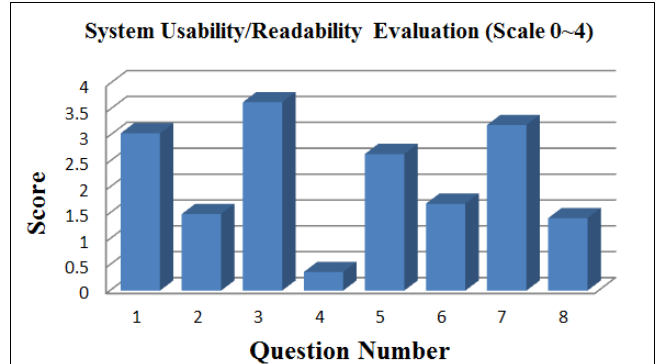
Figure 14. UFIT usability/readability evaluation for